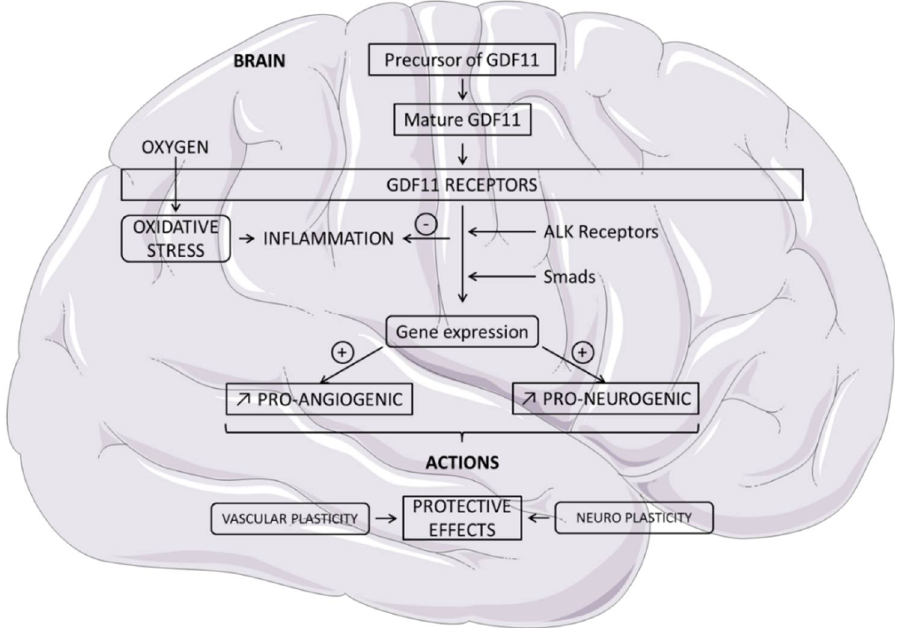
Figure 1. Schematic overview of the pro-angiogenic and pro-neurogenic properties of growth differentiation factor 11 (GDF11) in the brain. Mature GDF11 exerts its effects by binding to activin receptor-like kinases (ALK) inducing the phosphorylation of Smads. GDF11 reduces oxidative stress and inflammatory process.